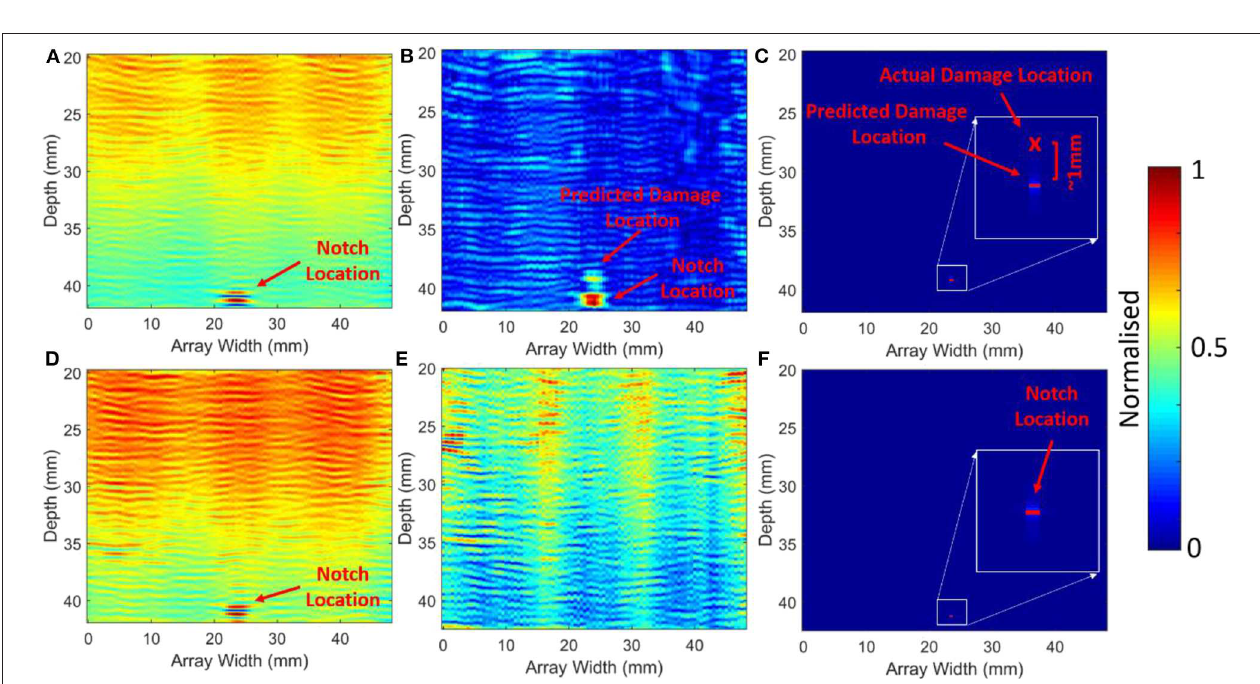
FIGURE 8 | SFC sample comparison of linear response vs. non-linear: (A) f 1 ; (B) M R 2 with delay on f 1 ; (C) β S + D with delay on f 1 ; (D) f 2 ; (E) M R 2 no delay between f 1 & f 2 ; (F) β S + D no delay between f 1 & f 2